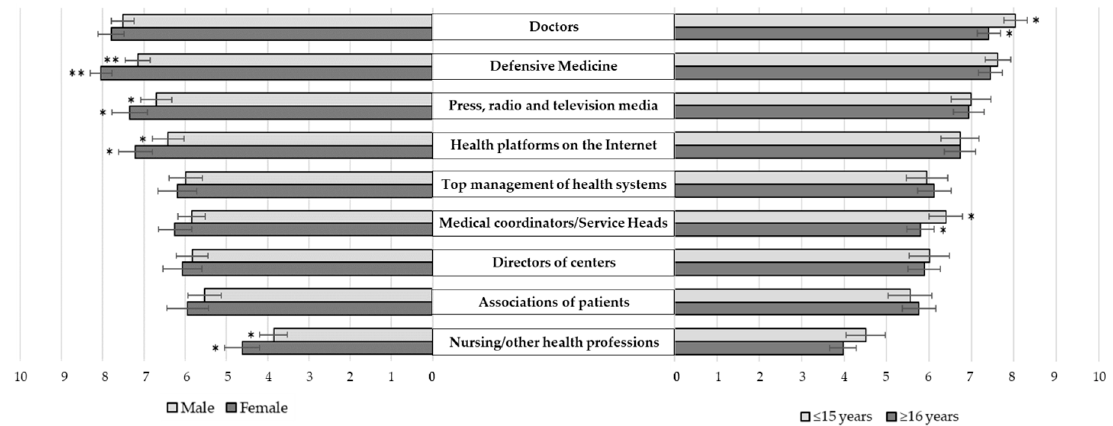
Figure 2. Degree of responsibility regarding overuse referred, according to the professional’s gender and work experience. Scale from 0 to 10, where 0 means “No responsibility” and 10 “Maximum responsibility” (with the expected 95% confidence interval of such percentages). * p < 0.050; ** p <